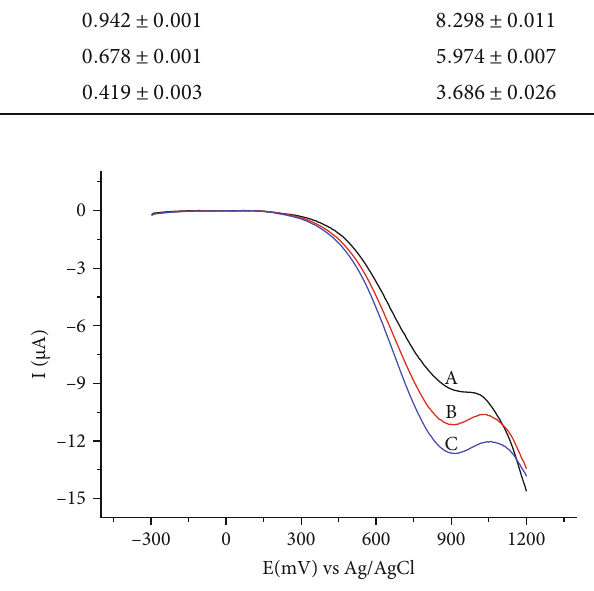
Table 1: The peak current, concentration of AA in the analyzed cabbage extracts, and mass of AA (mg/g) of powdered cabbage. Cabbage sample Oxidation peak current ( μ A) Concentration of AA (mM) Amount of AA (mg/g) Guld 12 : 638 ± 0 : 016